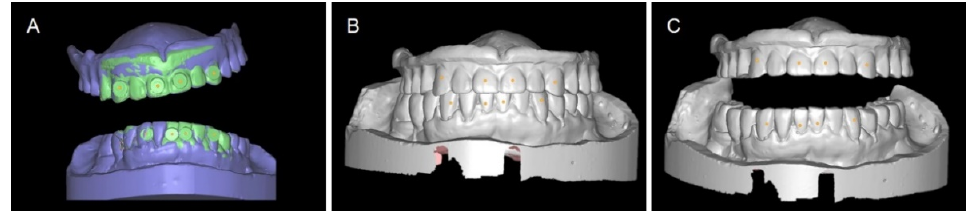
Figure 2. ( A ) Data scanned from all areas of the denture and plaster model were aligned. ( B ) The mouth was in closed state while tracking was in progress. ( C ) Tracking movement while opening the mouth.